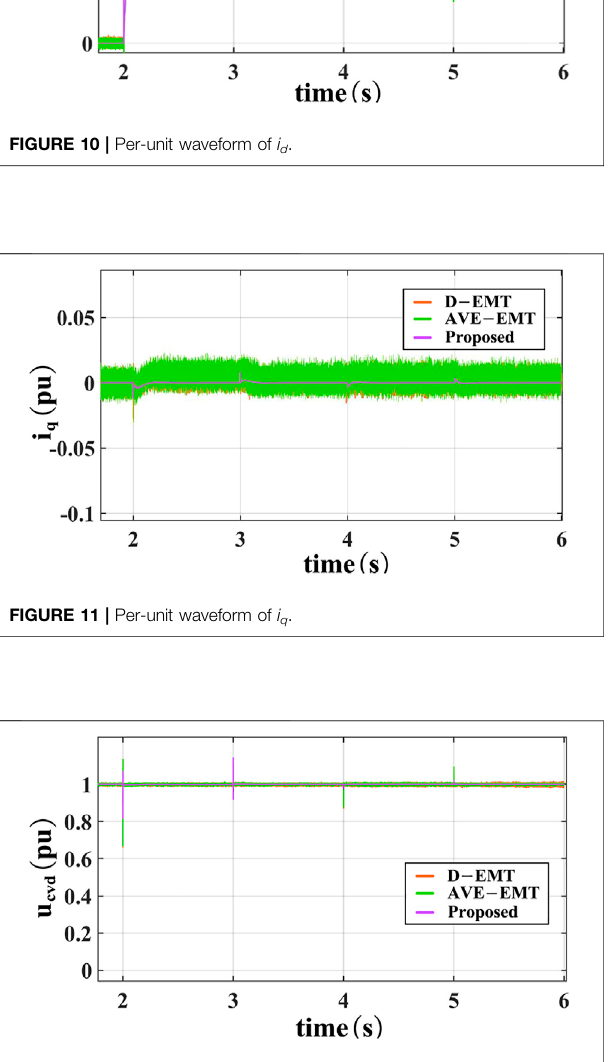
FIGURE 12 | Per-unit waveform of u cvd .